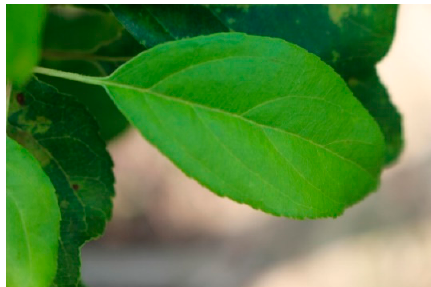
Figure 6. Healthy leaf.